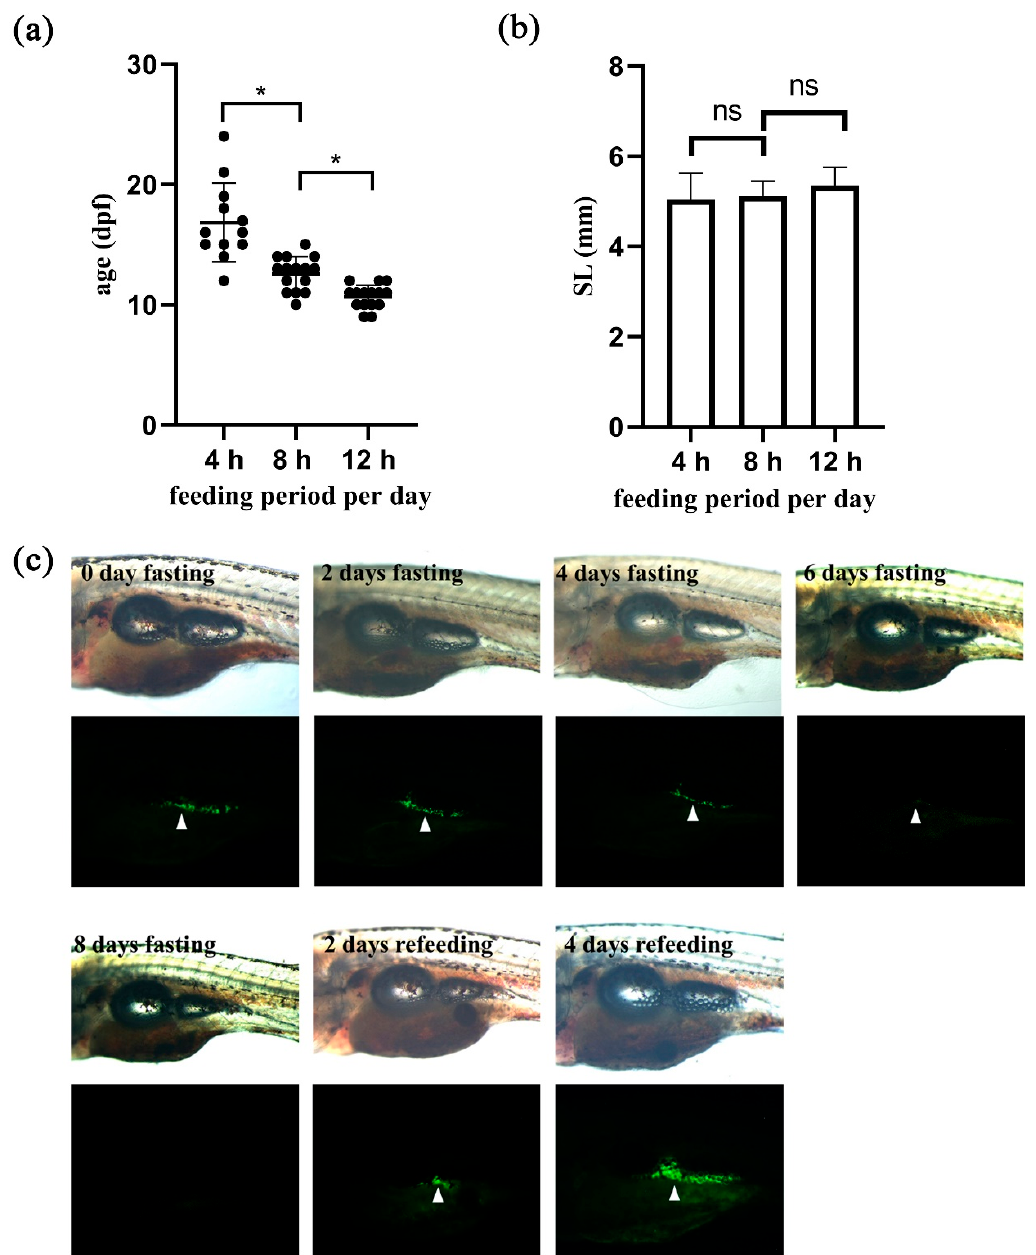
Figure 4. Nutrition influences on adipocyte development and maintenance. ( a , b ). Zebrafish embryos at 5 dpf were fed for different durations per day as indicated, and adipocyte development was examined. n ≥ 12. Repeat = 3. * indicates p < 0.05, and ns indicates p > 0.05. ( a ) Graphical presentation of the age of larvae that developed the first adipocyte in three groups. ( b ) Graphical presentation of the body length of larvae that developed the first adipocyte in three groups. ns, not significant. ( c ) 16 dpf larvae were selected and subjected to fasting for 8 days, and then refed for another 4 days. Representative bright field and fluorescent images are shown to orient the larvae with visceral adipose tissues marked by white arrowheads. n ≥ 5. Repeat = 3.